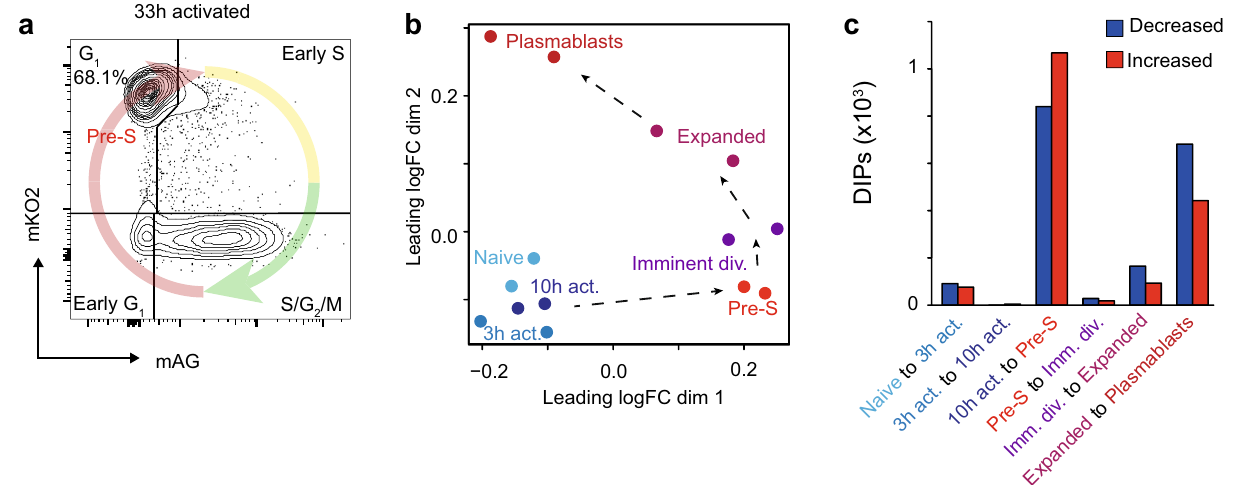
Fig. 5 Genome organizational changes occur prior to DNA synthesis. a Flow cytometry plot of G 1 stage FUCCI B cells that were fl ow cytometry puri fi ed by monomeric Kusabira Orange 2 (mKO2) and monomeric Azami Green (mAG) expression just prior to the fi rst division (33 h). b Multidimensional-scaling plot of the fi ltered and normalized logCPM values for interacting promoters during B-cell activation with Pre-S samples included. c Bar plot showing the number of differentially interacting promoters (DIPs) between each transition of B-cell activation with Pre-S samples included. Blue indicates decreased promoter interactions. Red indicates increased promoter interactions. Source data are provided as a Source Data fi